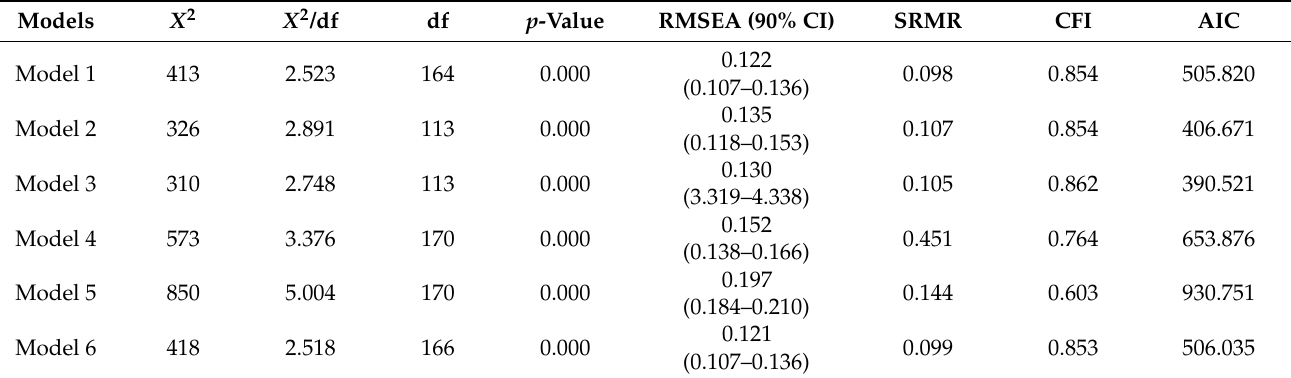
Table 3. CFA goodness-of-fit indices for the six SWBQp models ( N = 104).